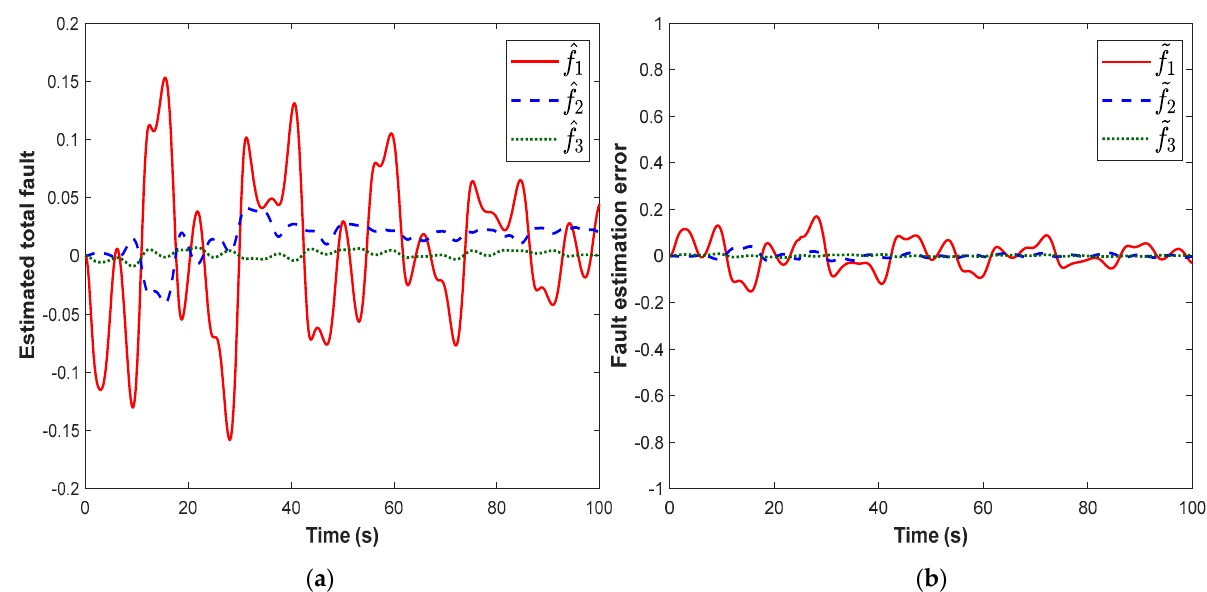
Figure 4. ( a ) Description of fault estimation; and ( b ) description of fault estimation error.